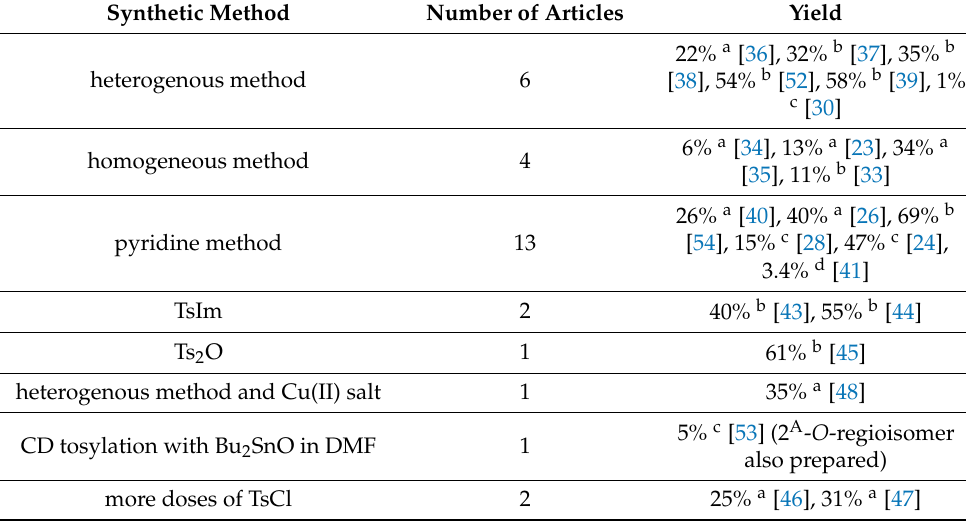
Table 1. Preparation of 6 A - O -aryl/alkyl-sulfonates of